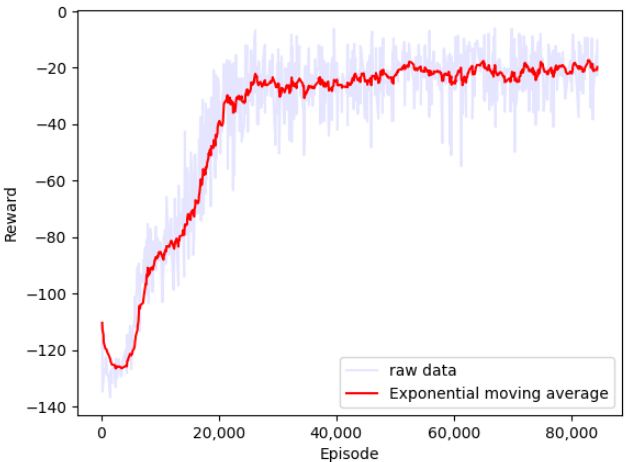
Figure 8. Simulation: reward of the proposed path planning in training.